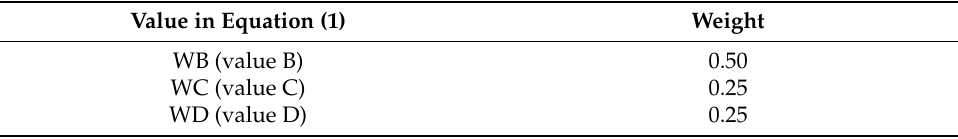
Table 3. Weights for the values of B, C, and D in Equation